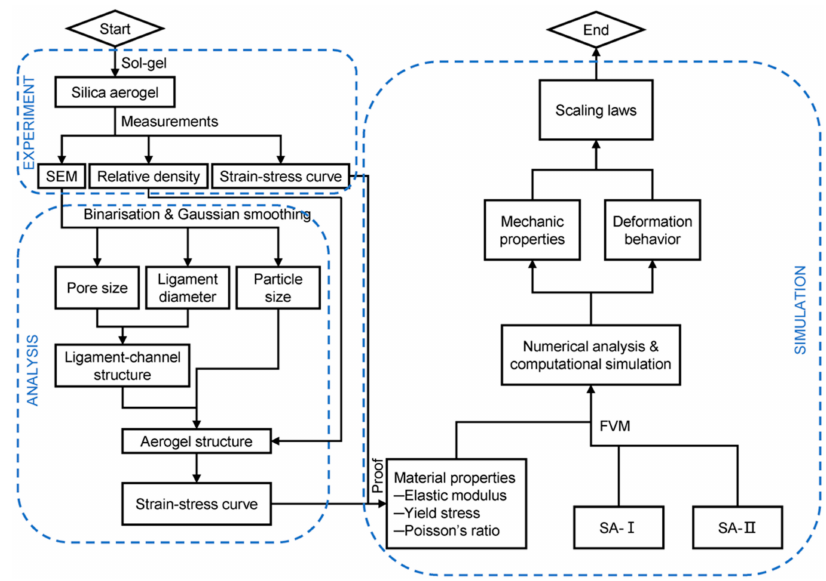
Figure 1. Flow chart for the experiment, modeling and simulation in this